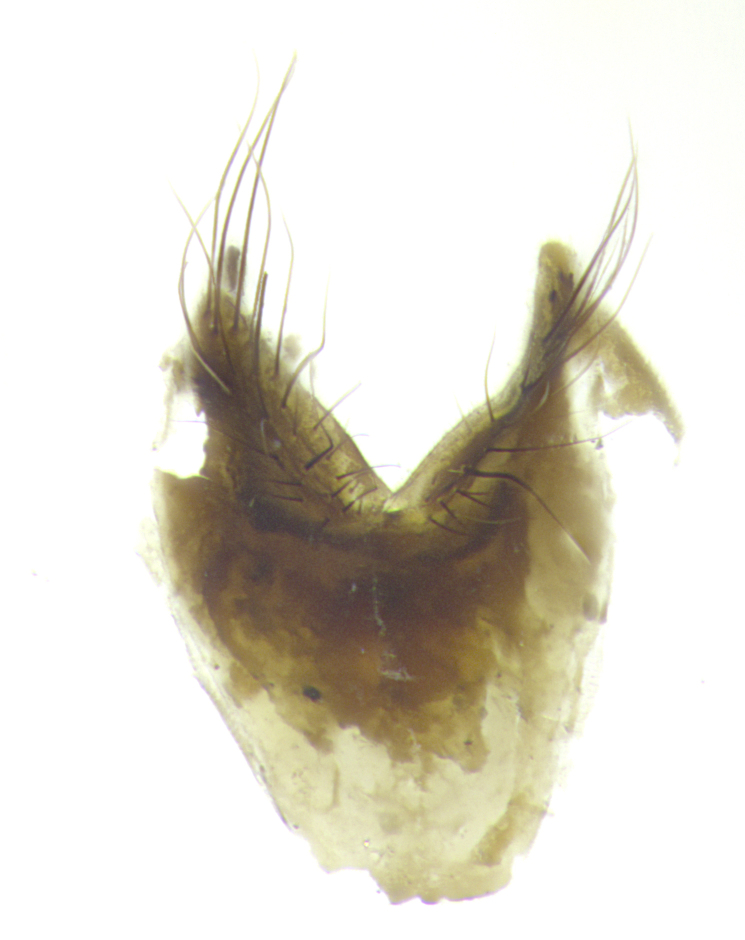
sternite 5, ventral view.